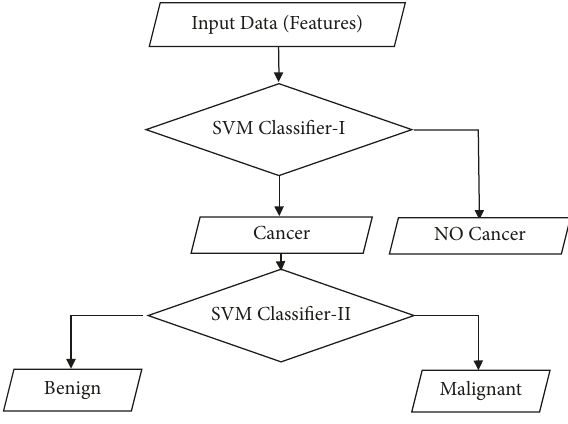
Figure 12: The flow of the two SVM classifiers. Table 4: The training and testing ratios distribution of samples from the MIAS